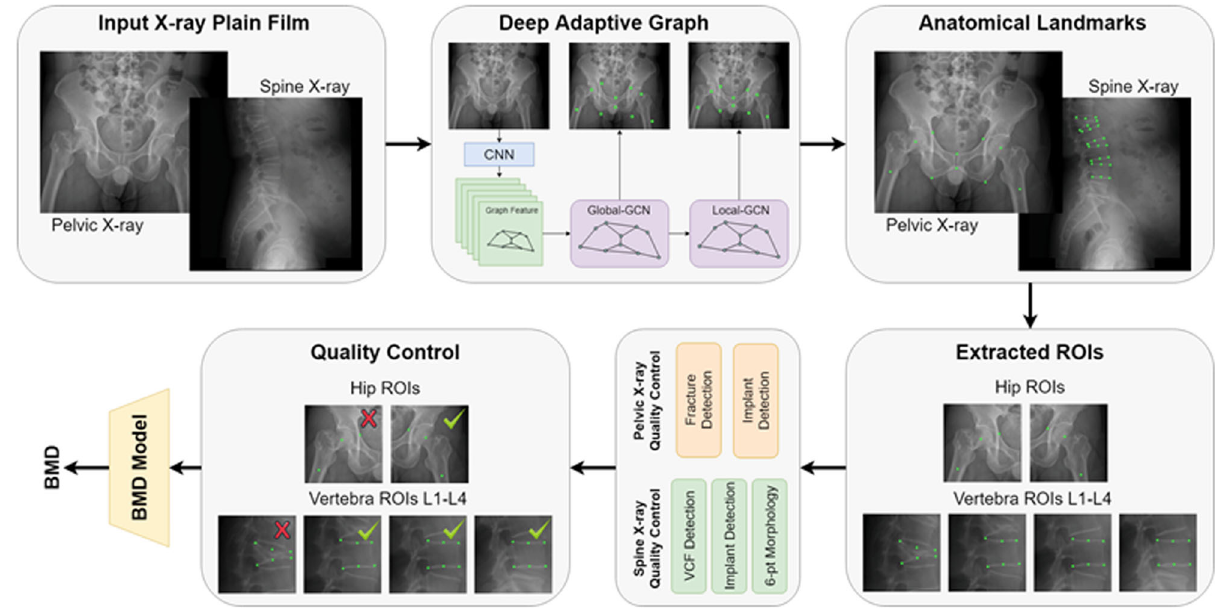
Fig. 1 Schematic representation of the work fl ow for hip and spine BMD estimation. Table 1 Patient characteristics of the study